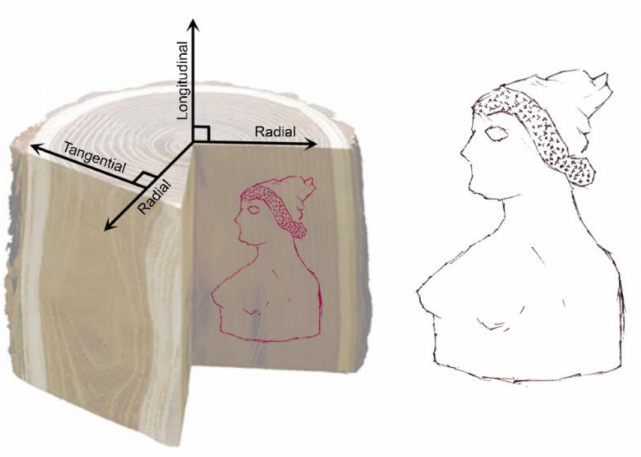
Figure 2. Artefact orientation inside a tree-trunk. Artistic interpretation of a female wooden figurine found in waterlogged condition at the excavations of the Temple of Artemis in Brau- ron, Greece (2500 years old) [20]. Image from a sector of coniferous wood stem adopted